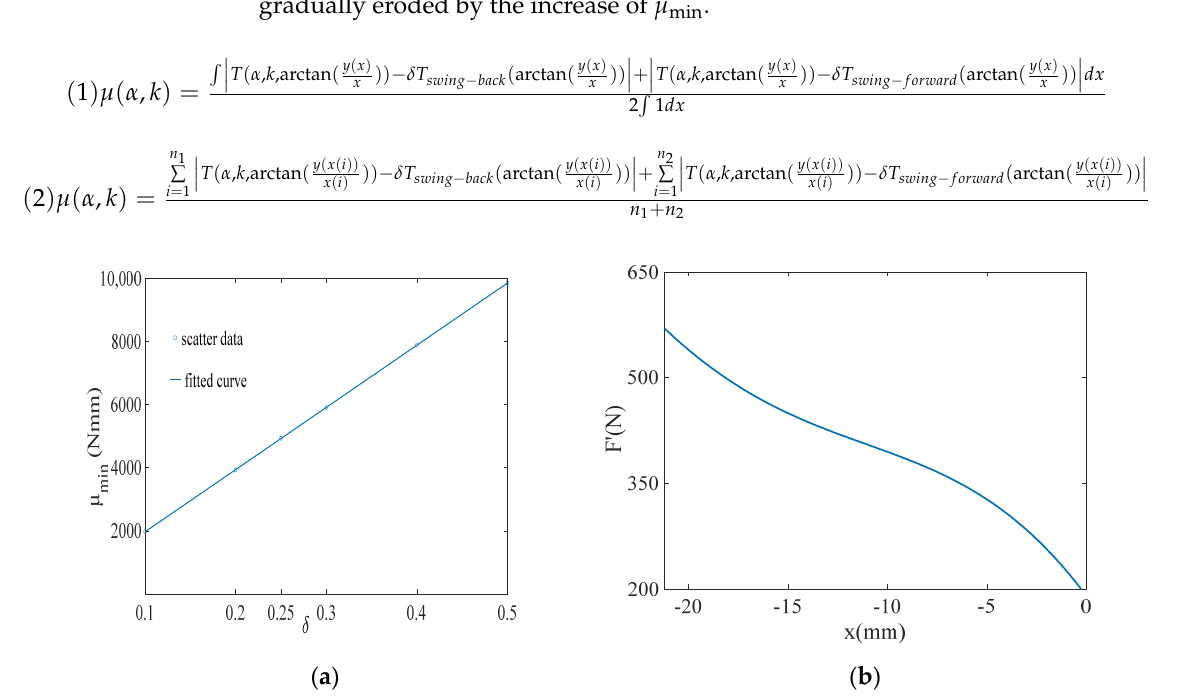
 of each  for the hip joint; ( b ) elastic force of the pressure spring. Figure 7. ( a ) Figure 7. ( a ) µ min of each δ for the hip joint; ( b ) elastic force of the pressure min According to Figures 6 and 7a, 0.2   is selected, expecting to provide 20% assis ‐ tance to the human body. When